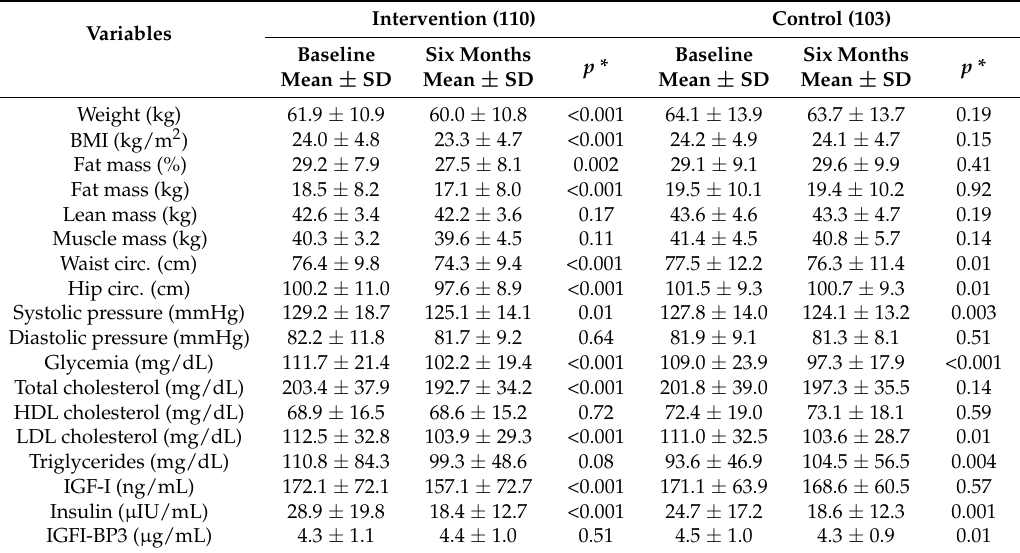
Table 3. Before-after analysis by randomization group (213